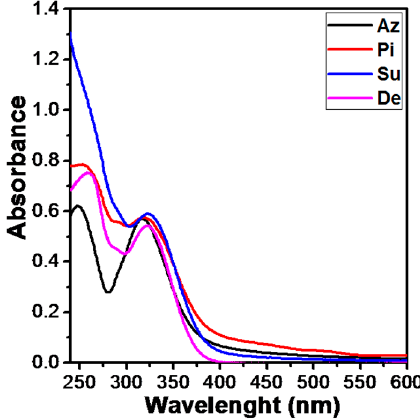
Figure 2. The UV-Vis absorption spectra of TPE-Se , TPE-Az , TPE-Su and TPE-Pi (10 μ M).